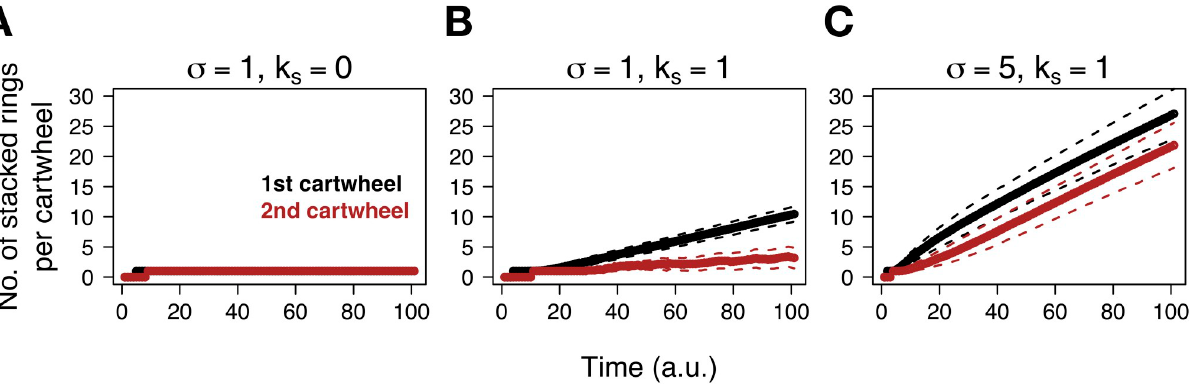
Fig 4. Cartwheels elongate continuously and show a distribution of lengths along time. The average number of complete rings present in the first (black) and second (red) cartwheels across all simulations are plotted as a function of time, for the indicated values of σ and k the average ± standard deviation. We used default simulations conditions as indicated in Fig 3 and in the Models and methods section. Note that k s = 0 represents absence of stacking.